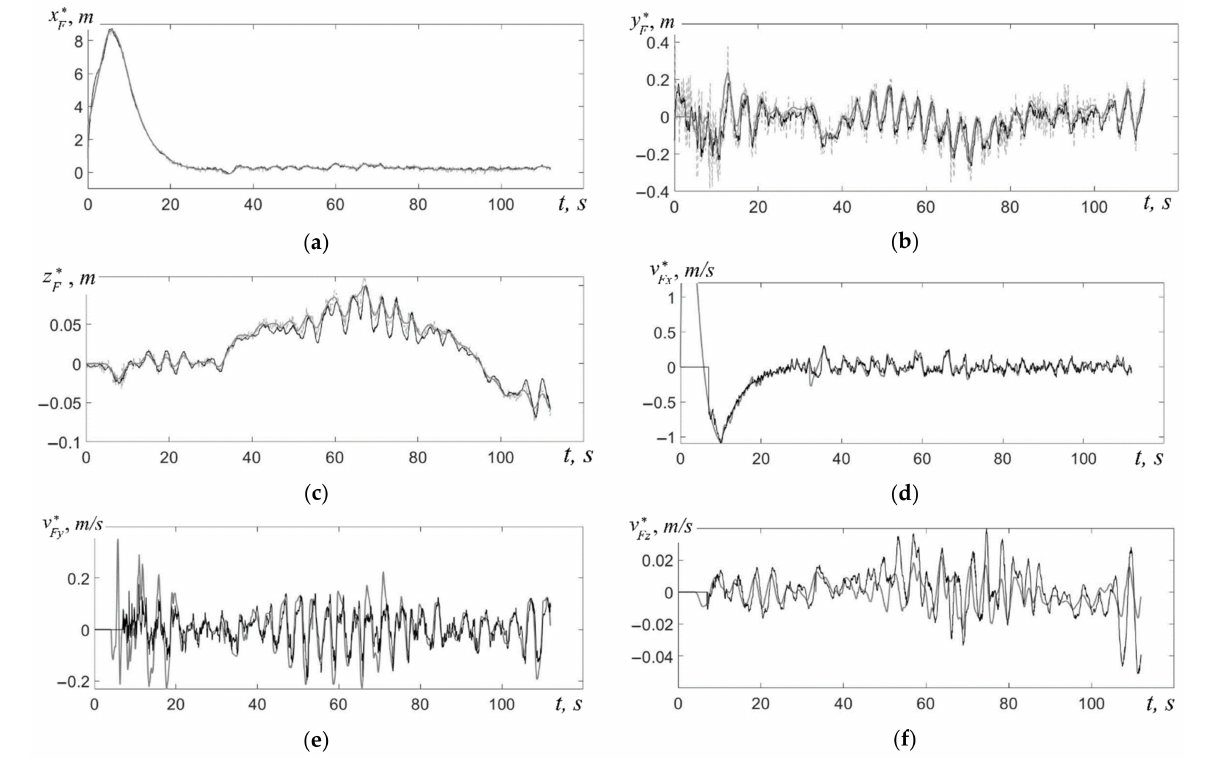
Figure 8. The changing of the true and the predicted values of coordinates (( a ) is the x ∗ ( c ) is the z ∗ ) and speeds (( d ) is the υ ∗ F taking into account the errors in determining the position and orientation of the